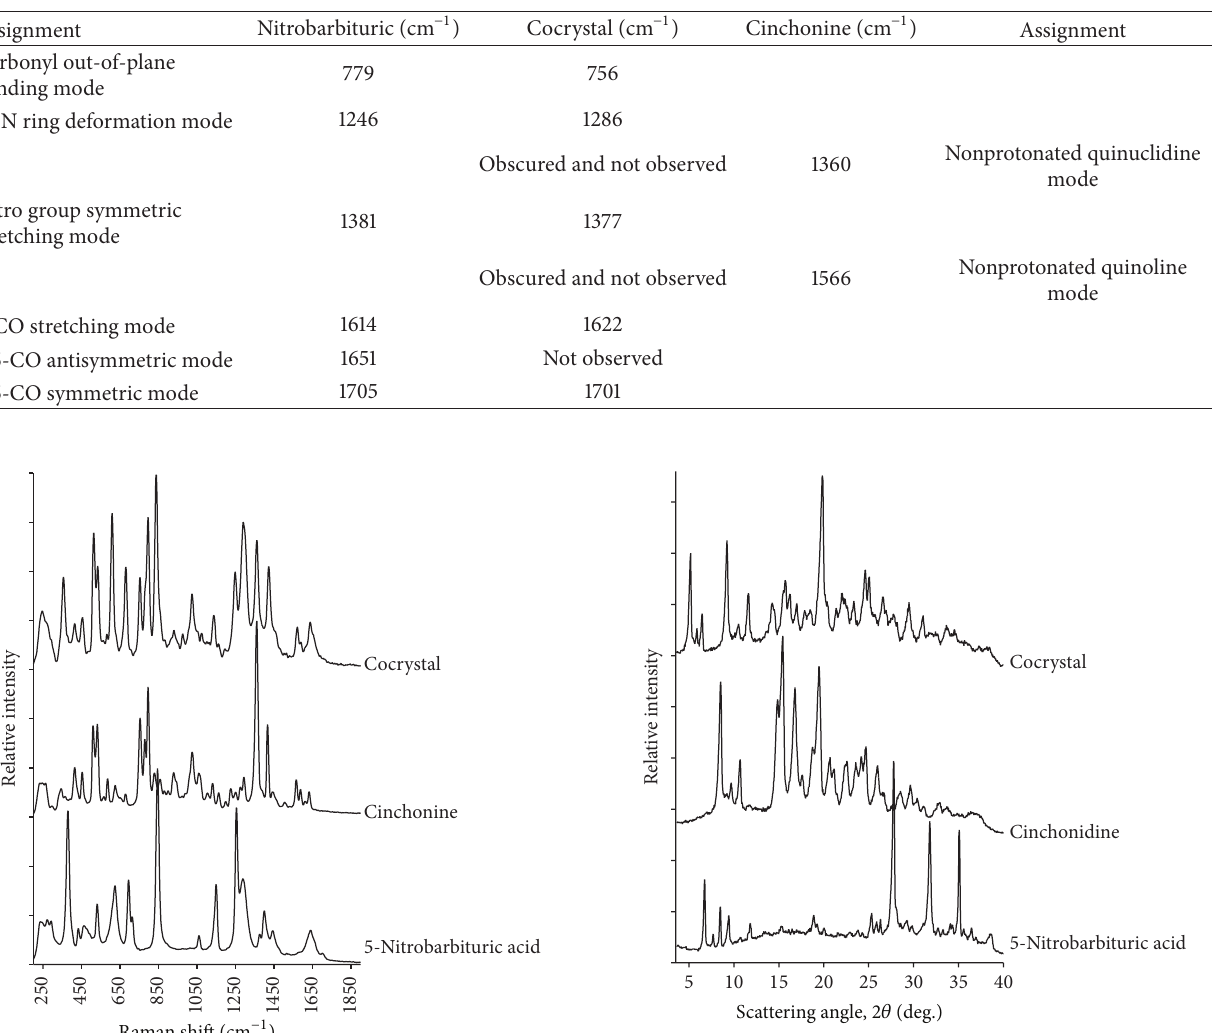
Table 1: Assignments of the major bands in the fingerprint region of the infrared absorption spectra of 5-nitrobarbituric acid, cinchonine, and their 1:1 cocrystal product.